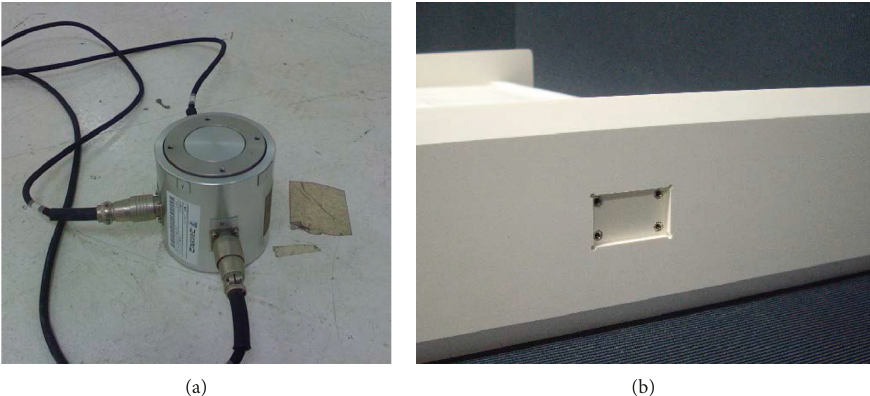
Figure 7: Load cell and mount system: (a) 3-component load cell; (b) mount points on the side of the